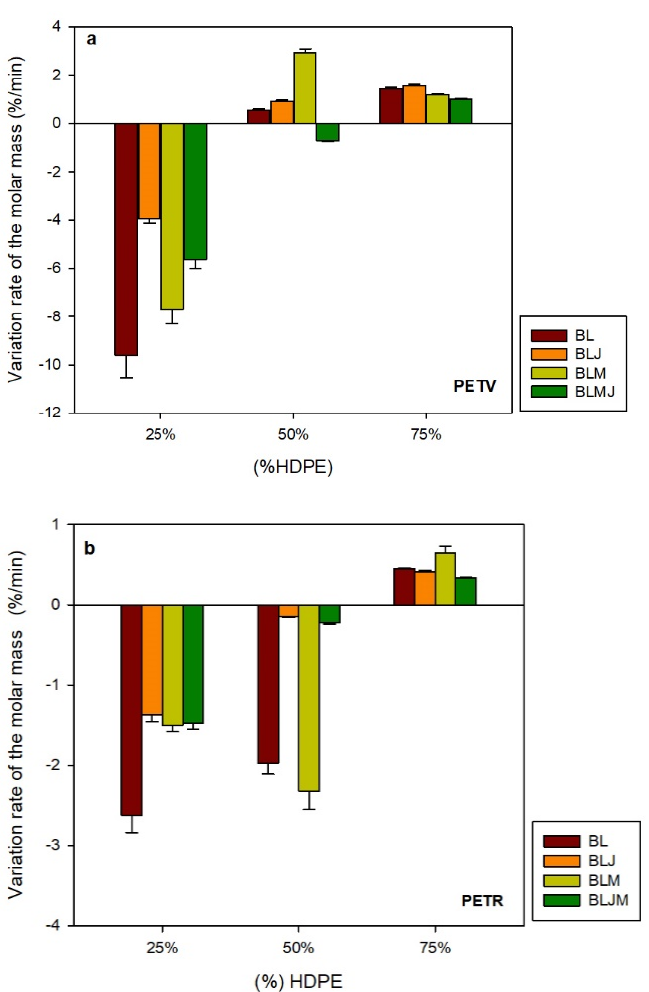
Figure 5. Relative rate of change of the weight average molar mass of different components as a function of HDPE content, over the same time interval. ( a ) PETV and ( b ) PETR.